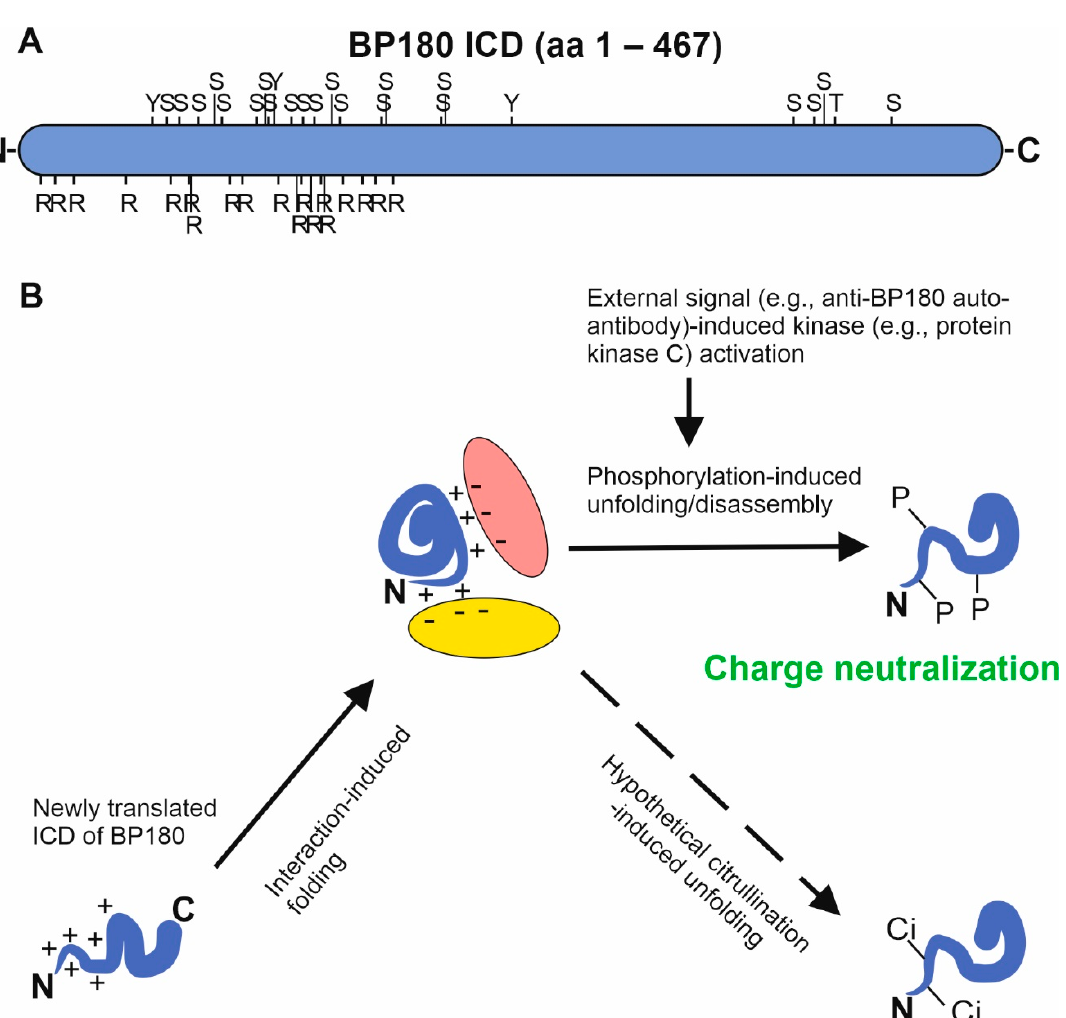
Figure 4. Charge changing post-translational modifications of BP180 ICD. ( A ) The localizations of serine (S), threonine (T), and tyrosine (Y) residues which are putative phosphorylation sites with >0.9 score in NetPhos 3.1 analysis and arginines (R) present in BP180 ICD. ( B ) A speculative model, how protein–protein interactions with negative charged proteins (represented by yellow and orange ellipses) may drive folding of BP180 ICD (blue), and the phosphorylation and/or hypothetical citrullination may lead to protein complex disassembly and BP180 ICD unfolding. P = phosphate group. Ci = citrulline. Aa = amino